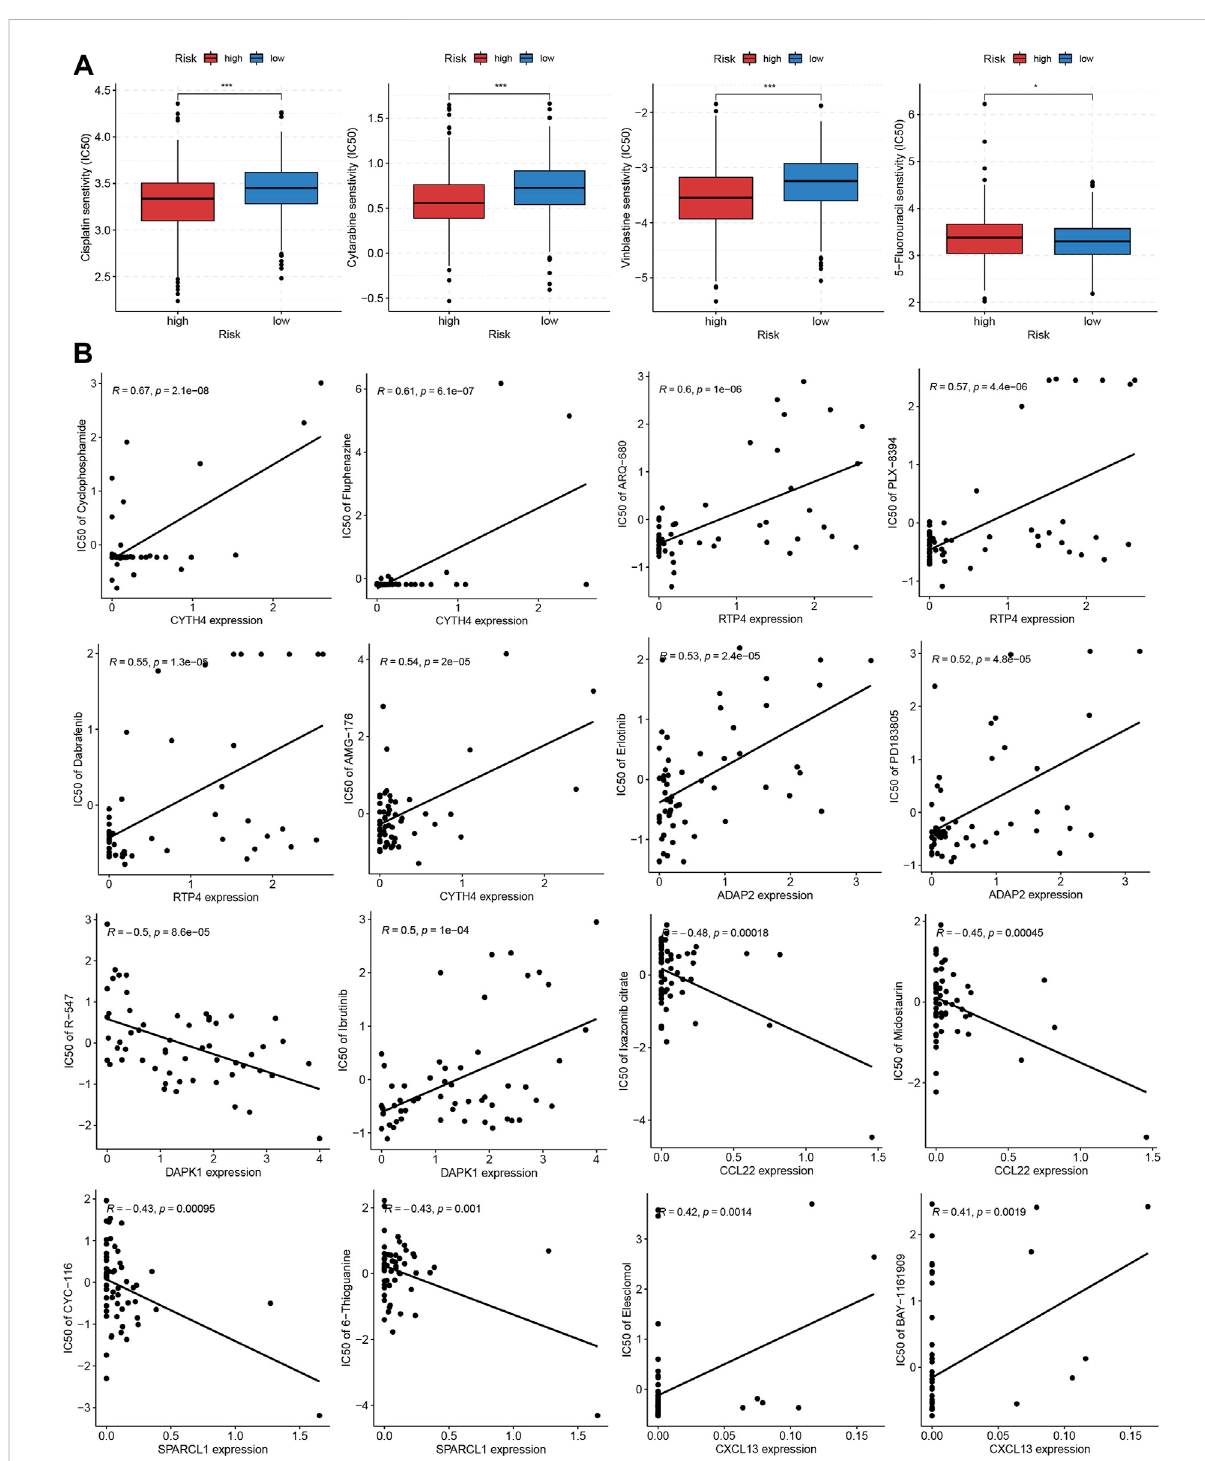
FIGURE 9 CorrelationofTRMRGriskscoresignaturewithsensitivitytoanti-tumordrugs. (A) DifferencesinIC50valuesforcisplatin,cytarabine,vinblastine and 5- fl uorouracil between high and low risk patients. (B) Pearson correlation analysis of TRMRG expression levels with IC50 values for anti-tumor drugs in NCI-60 cell lines. Statistical Signi fi cance: * p < 0.05; *** p <